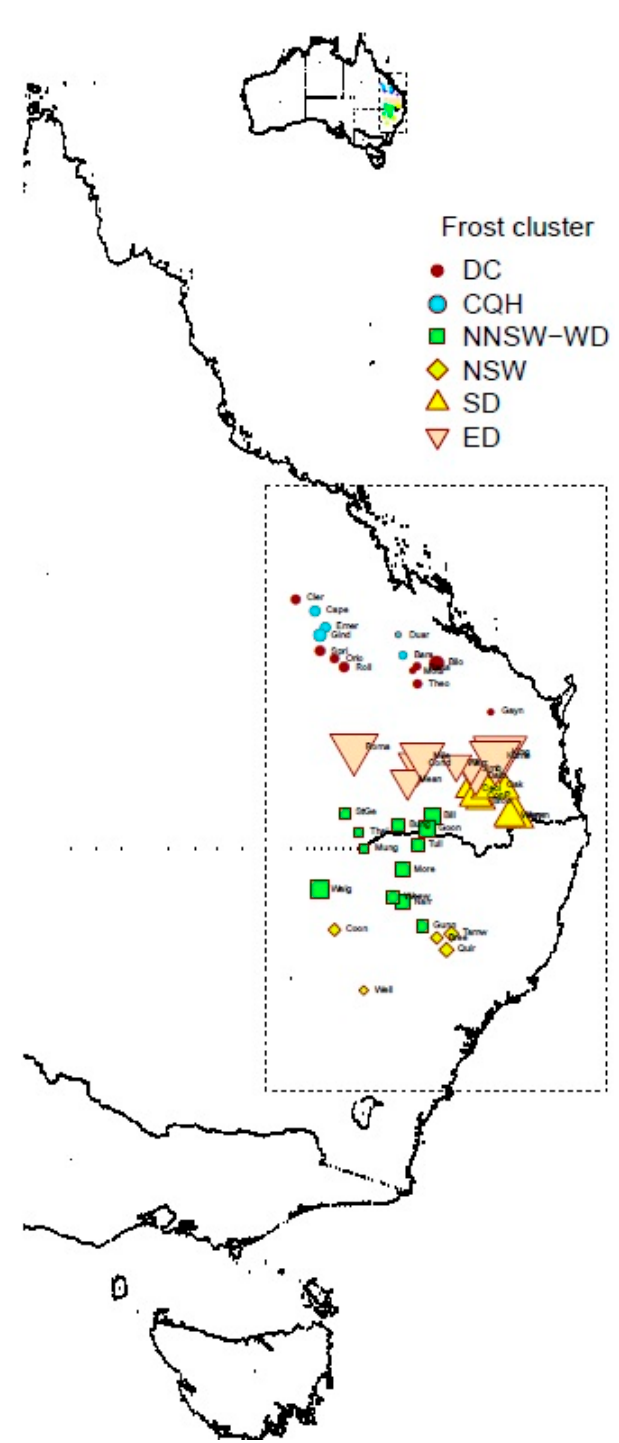
Figure 3. Spatial representation of locations representing different sub-regions of frost risk with the symbol size (with abbreviated names) representing the relative risk of frost in terms of annual number of post-flowering frost events based on 15-April sowing. The sub-regions are CQH = Central Queensland Highlands, DC = Dawson Callide, NNSW-WD = Northern New South Wales and Western Downs (Queensland), NSW = New South Wales, SD = Southern Downs, DD = Darling Downs.